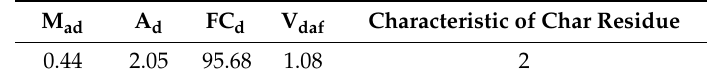
Table 5. The entire quality analysis of coke. M ad : Air drying base content. A d : ash content. V daf : Volatile content. FC d : Fixed Carbon content.